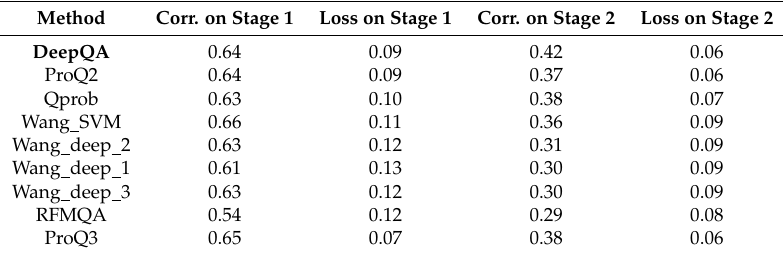
Corr.: average per-target correlation, Pearson’s correlation between the real and predicted GDT TS scores of all models; Loss: average per-target loss, defining the difference between the GDT TS scores of the selected model and the best model in the model